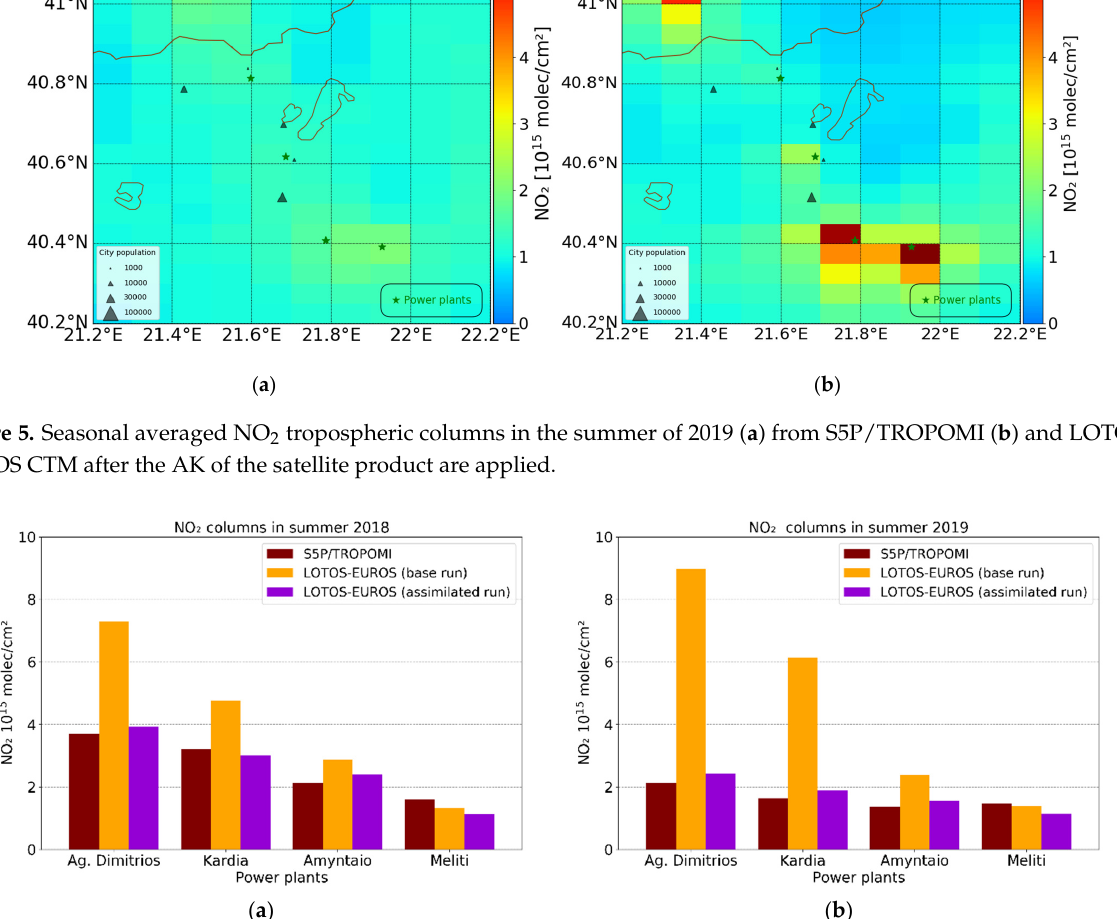
Figure 6. Mean tropospheric NO 2 columns observed by TROPOMI instrument (brown bars), simulated by LOTOS-EUROS (orange bars) and assimilated with S5P/TROPOMI (purple bars) for ( a ) the summer of 2018 and ( b ) the summer of 2019. Table 2. Statistics (mean values, standard deviation and bias) of the S5P/TROPOMI and LOTOS-EUROS NO 2 tropospheric columns in 10 15 molec cm − 2 for the summer of 2018 and 2019 over the four power plants. Power Plants 2018 2019 TROPOMI LOTOS-EUROS Bias TROPOMI LOTOS-EUROS